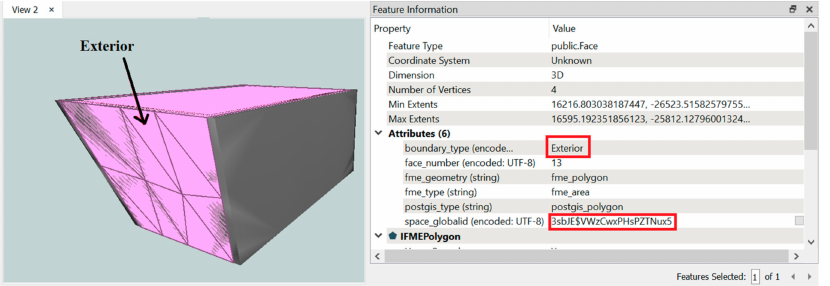
Figure 27. The Exterior boundary type has been assigned to the face of a legal space with oblique walls.